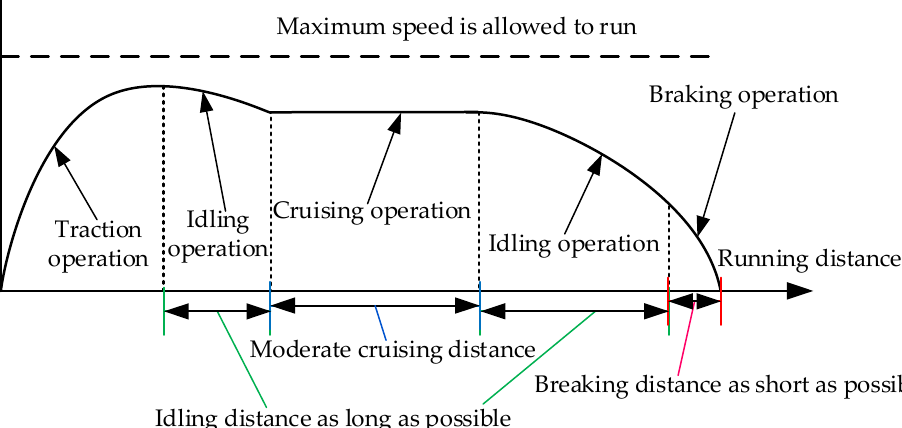
Figure 1. Schematic diagram of maximum idling distance optimization.